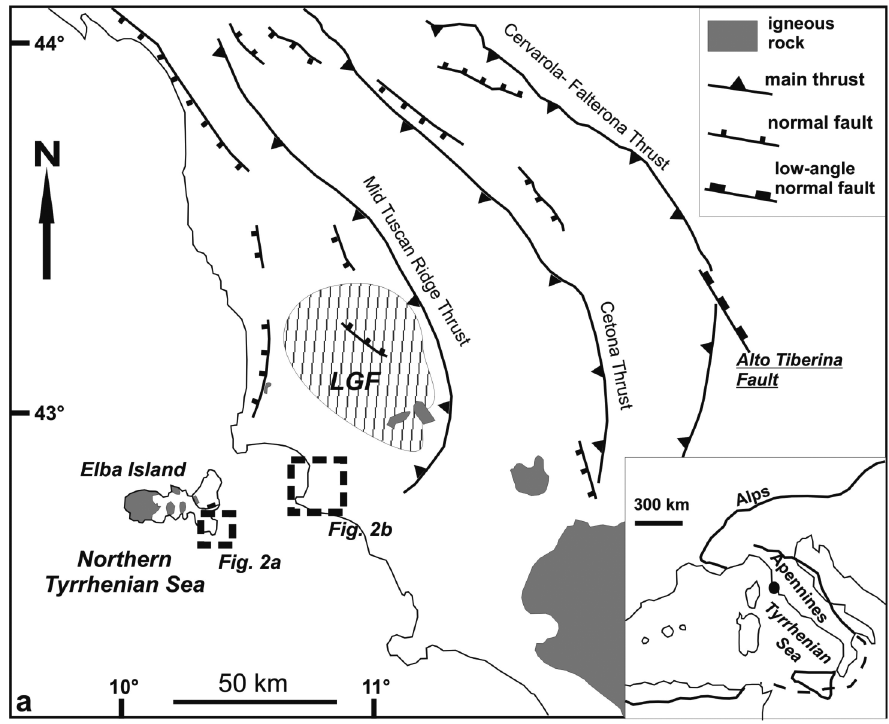
Figure 1. Sketch map of geological setting of studied examples (black dashed boxes), LGF: Larderello Geothermal Field. Dot in the inset is the location of this